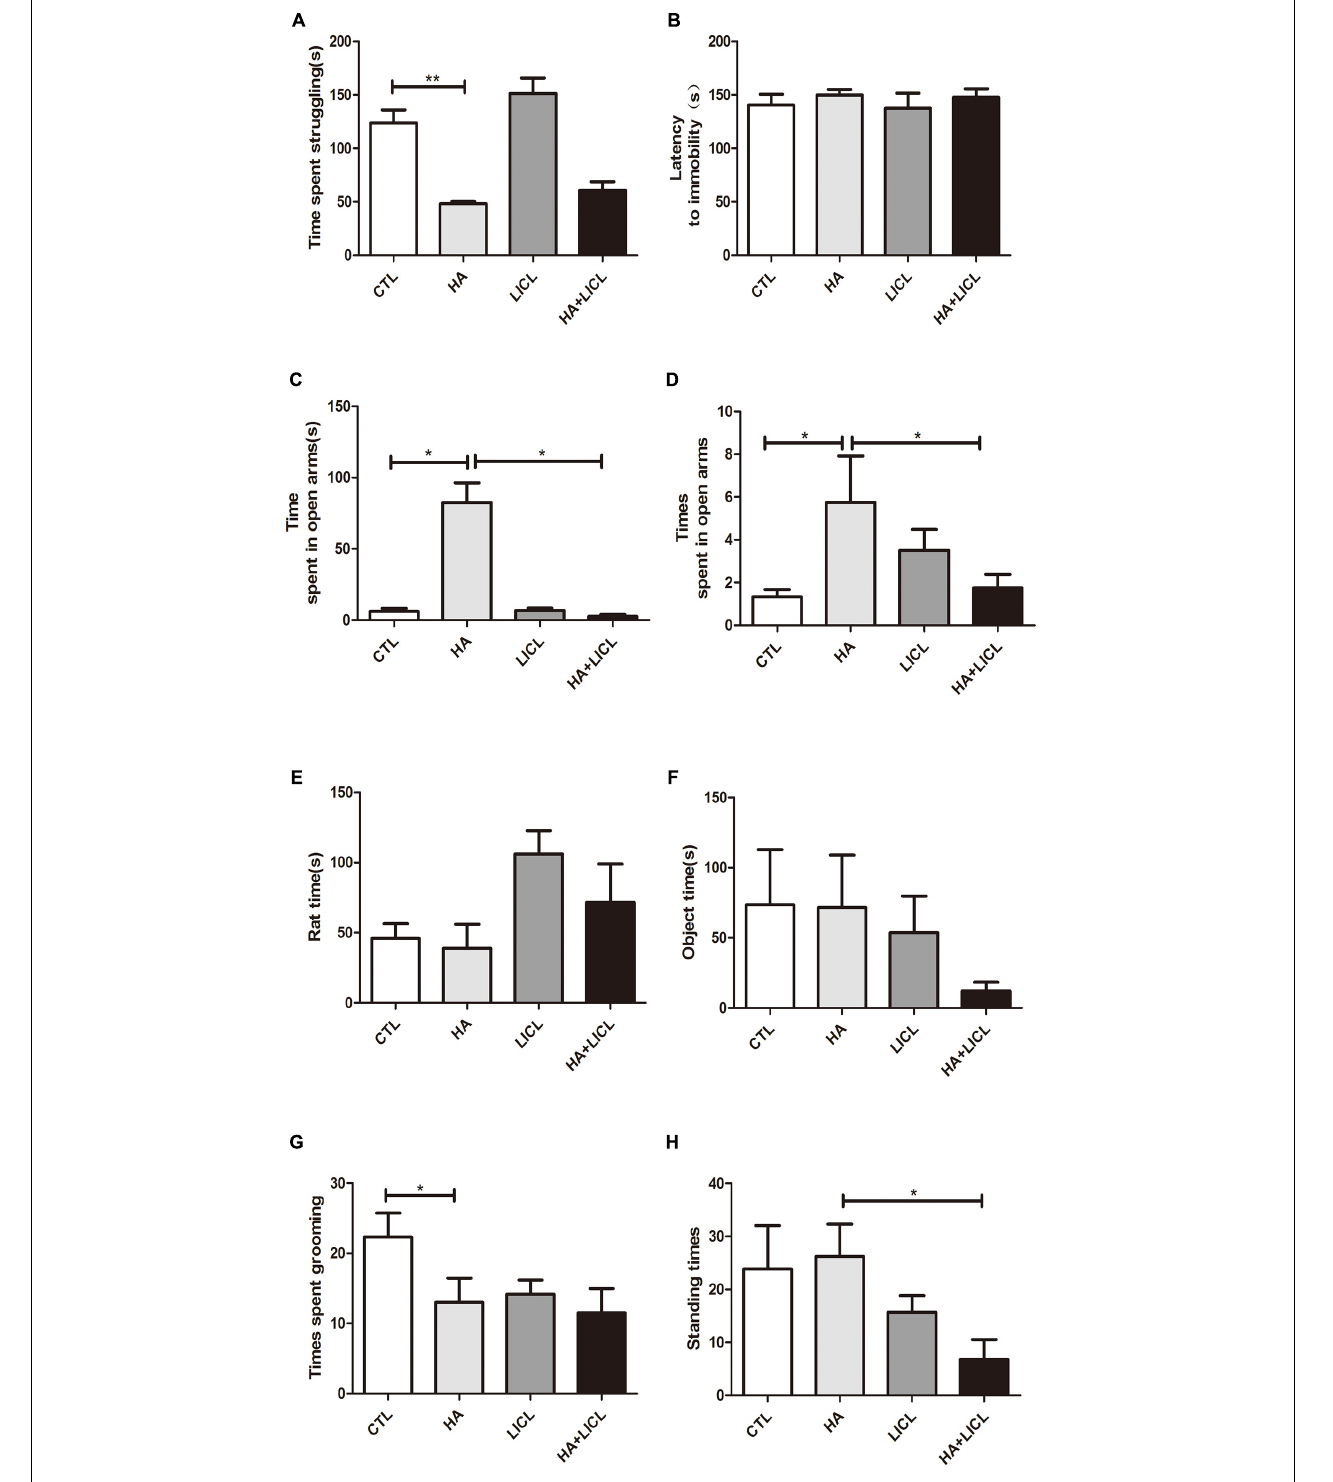
FIGURE 2 | Behavioral test of the offspring. (A) Time spent in struggling was significantly decreased after HA treatment (B) No significant difference was found on the time of latency to immobility in treatment group. (C,D) Both the time and times of their entering the open arms were higher in the HA group as compared to the CTL group and lower in the HA+LICl group as compared to the HA group. (E,F) The time of communication with unfamiliar rats and object showed no significant difference following letrozole and lithium chloride treatment. (G) The stereotyped behavior of grooming were decreased, (H) and the standing behavior were not improved after lithium chloride intervention. ∗ p < 0.05, ∗∗ p <